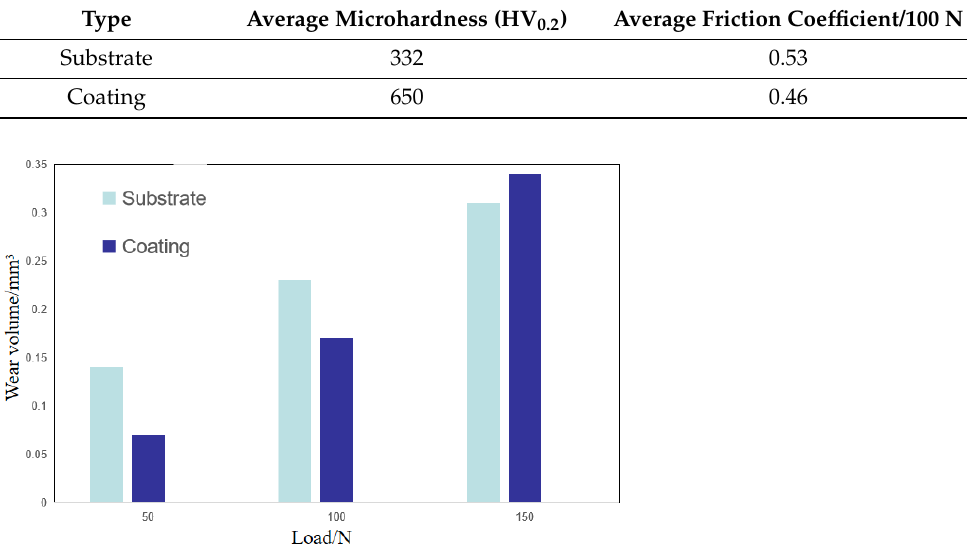
Table 6. Fretting wear test results of contact zone.